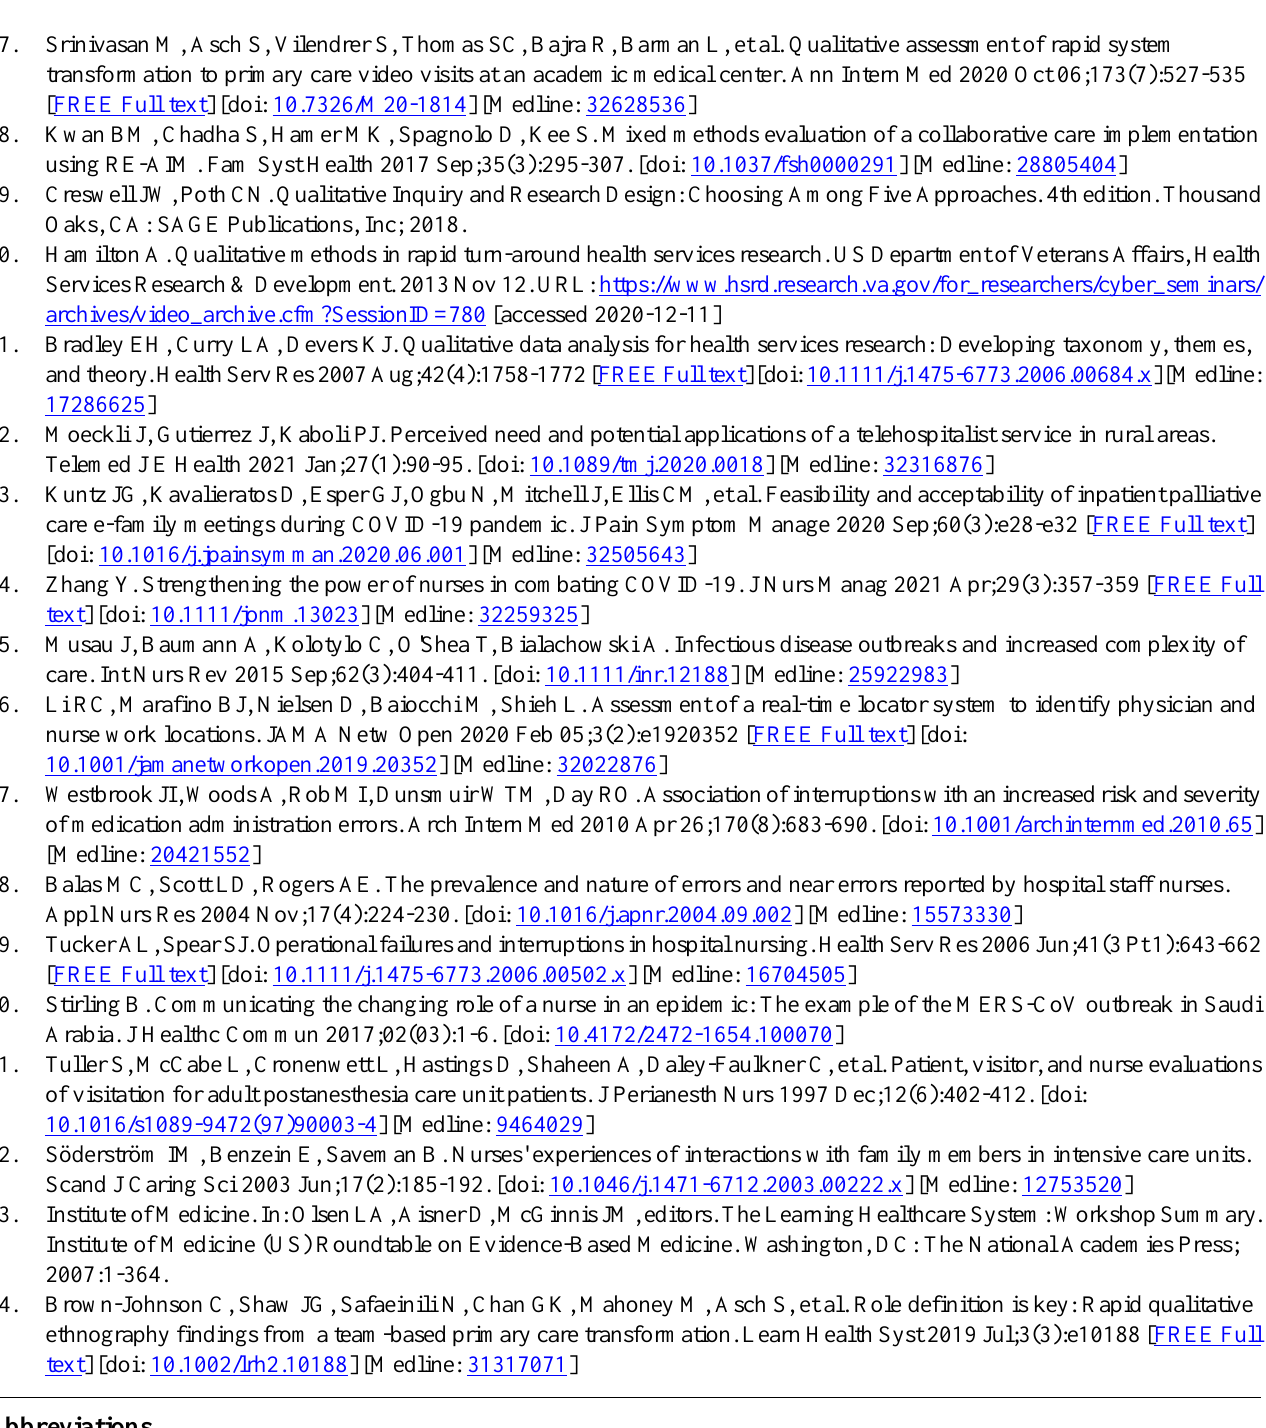
IT: information technology PPE: personal protective equipment RE-AIM: reach, effectiveness, adoption, implementation, and